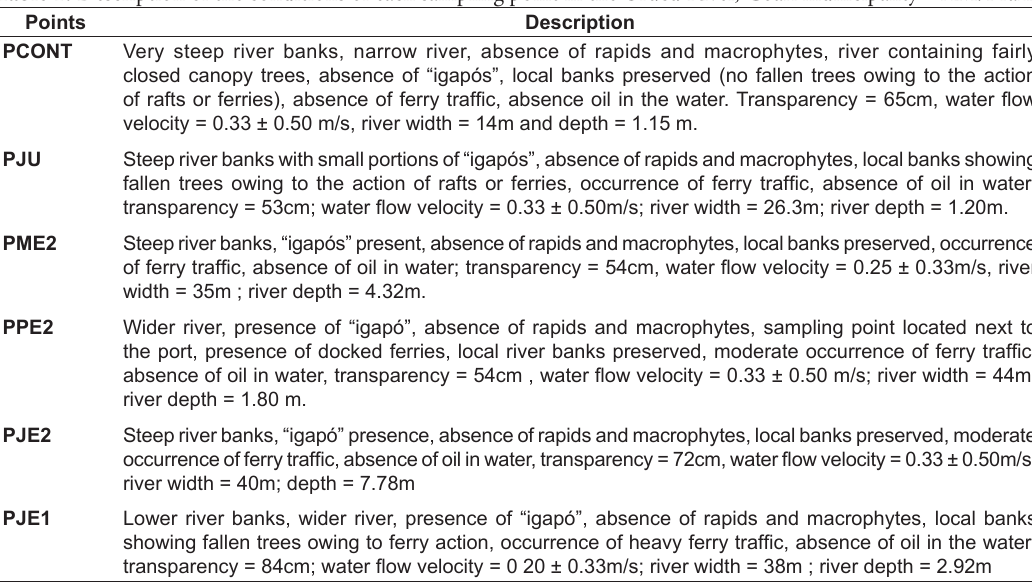
Table 1. Description of the conditions of each sampling point in the Urucu River, Coari municipality –